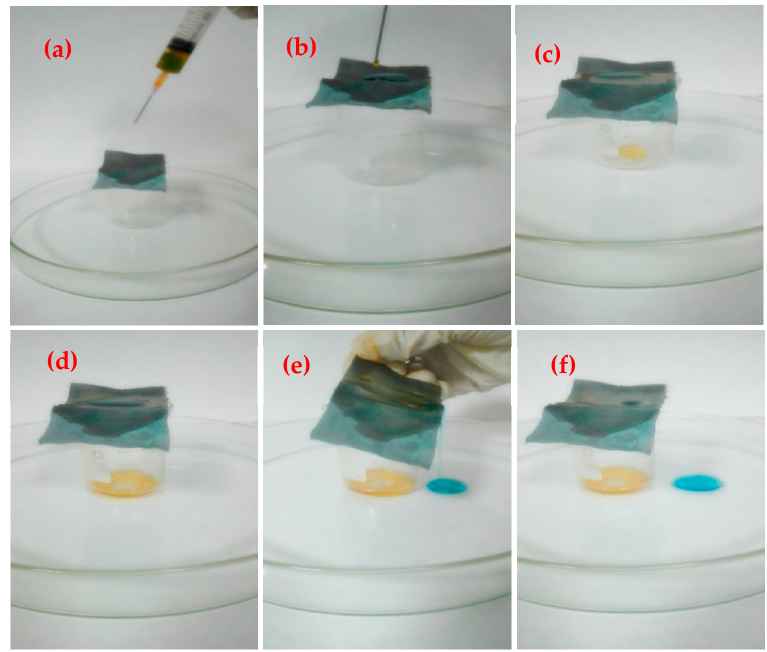
Figure 12. Separation process of cooking oil and water mixtures. ( a , b ) Oil-water separation operation; ( c , d ) Oil-water separation process; ( e , f ) Operation after separation of oil-water.